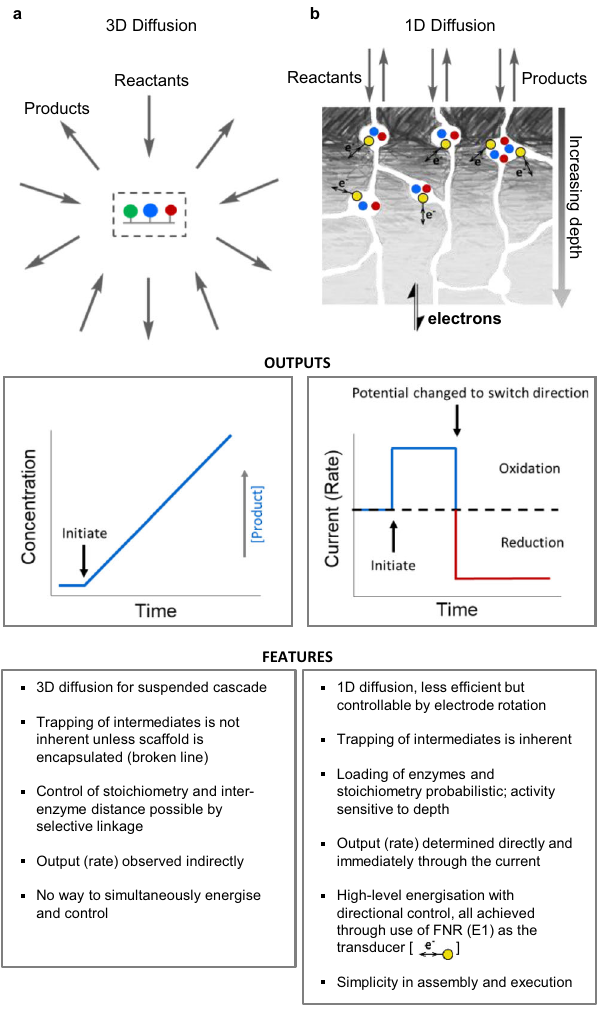
Fig. 1 Comparing nanocon fi ned enzyme cascades. Comparisons between: a catalysis by a nanocon fi ned enzyme cascade immobilized on a scaffold that is suspended in solution; b catalysis by an enzyme cascade con fi ned in zones of nanopores formed naturally by electrodeposition of indium tin oxide nanoparticles on a conducting support. The nanopore-con fi ned cascades are energizable and directly observable via electron fl ow through the transducer ferredoxin-NADP + reductase (E1).